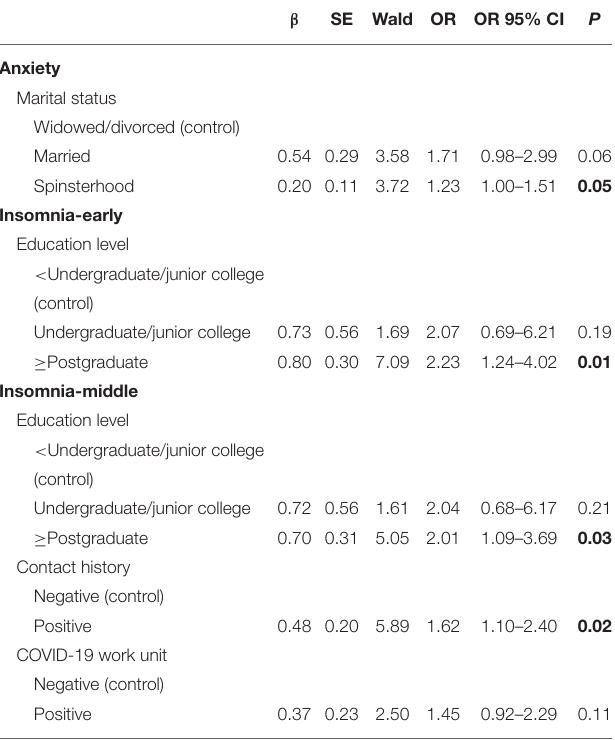
TABLE 5 | Factors of influencing adverse psychological reactions in frontline group by logistic regression analysis.